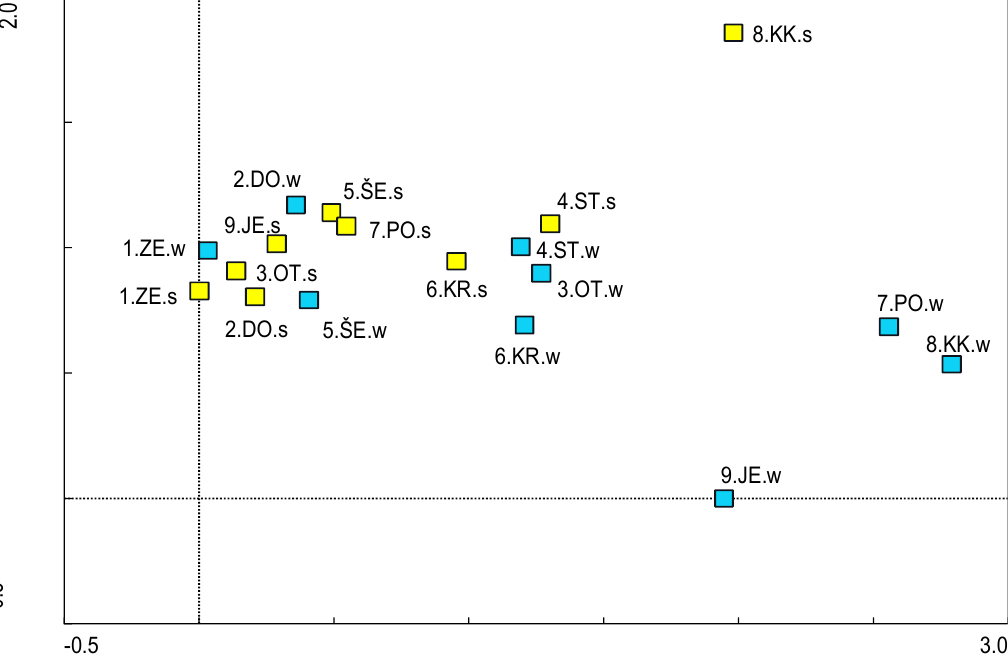
Figure 2. Ordination diagram of detrended correspondence analysis (DCA). The symbols for winter samples are blue, labeled “Site_w” and the symbols for summer samples are yellow, labeled “Site_s”.